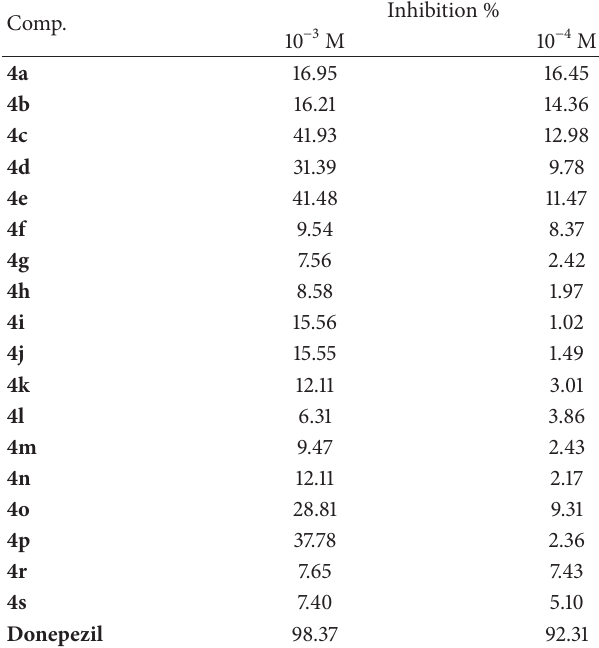
Table 2: % Inhibition potency of the compounds on AChE at 10 − 3 – 10 − 4 M concentrations.